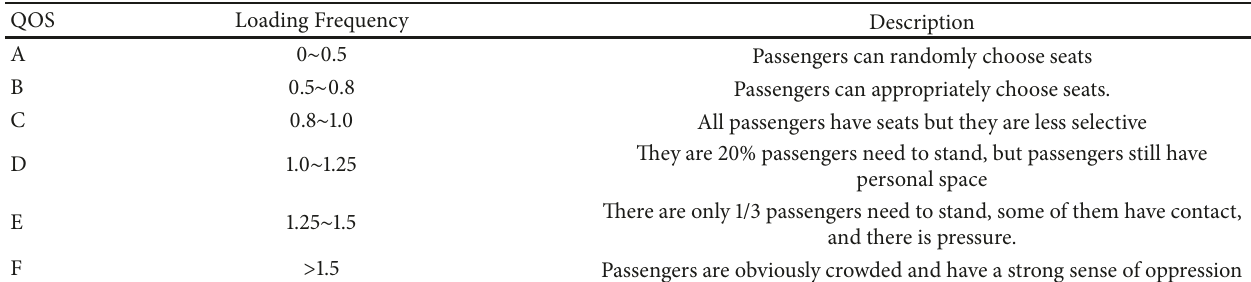
Table 2: Classification of crowding service quality [20].